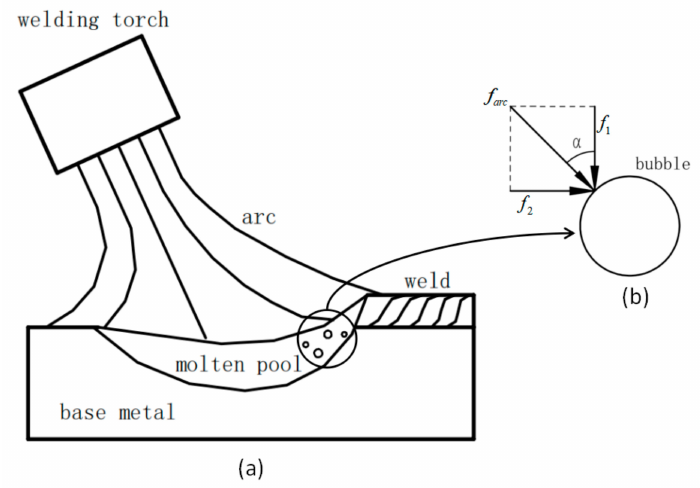
Figure 5. ( a ) Bubble schematic during welding and ( b ) force analysis diagram on bubbles in molten